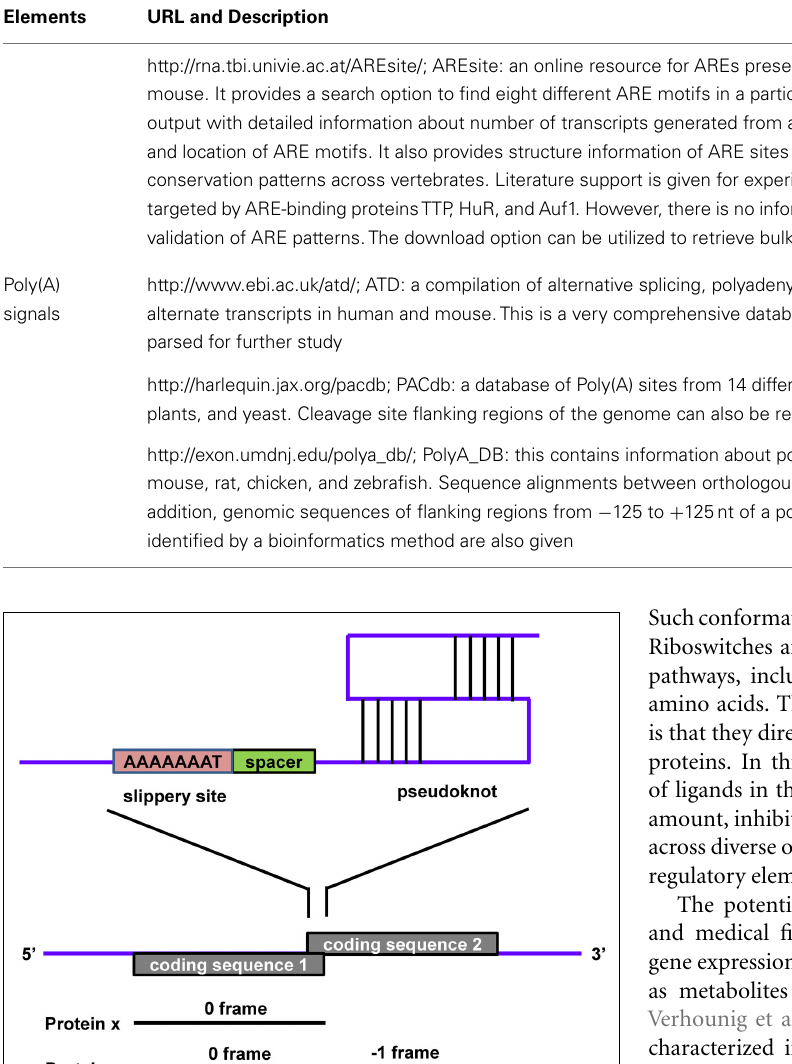
or early termination of transcription to prevent gene